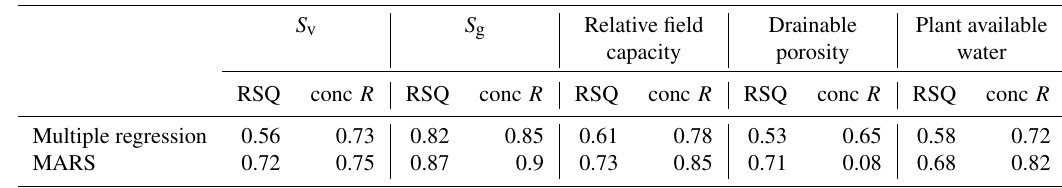
Table 3. Soil water retention characteristics: fit results from PTFs based on LandIS data (BD, texture (clay, silt and sand) and organic C